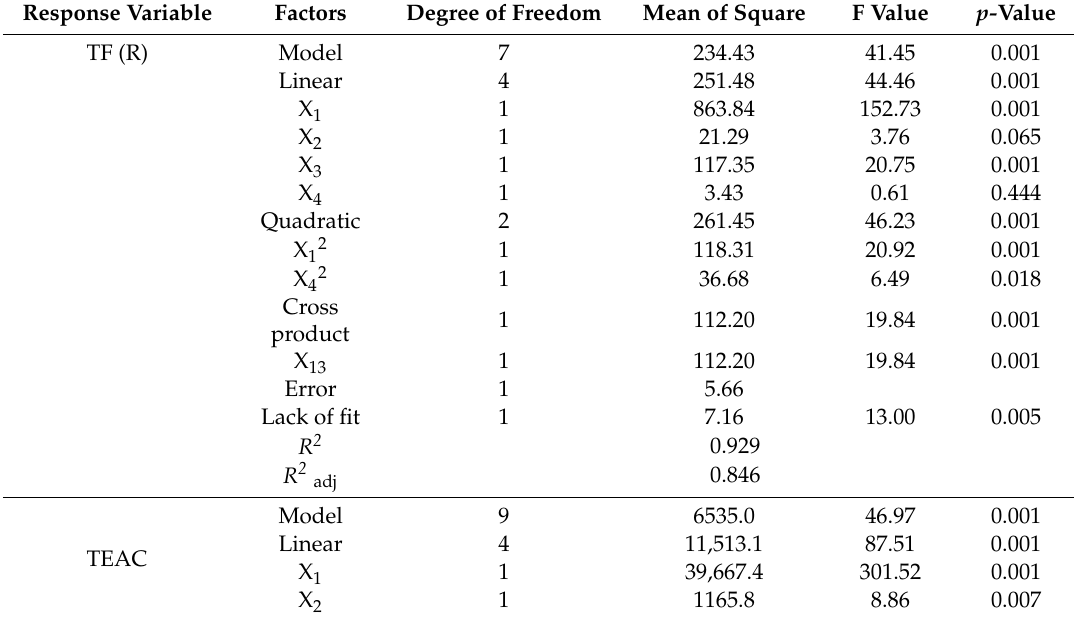
Table 3. Analysis of variance of RSM for the for total flavonoids, TEAC and FRAP values. Response